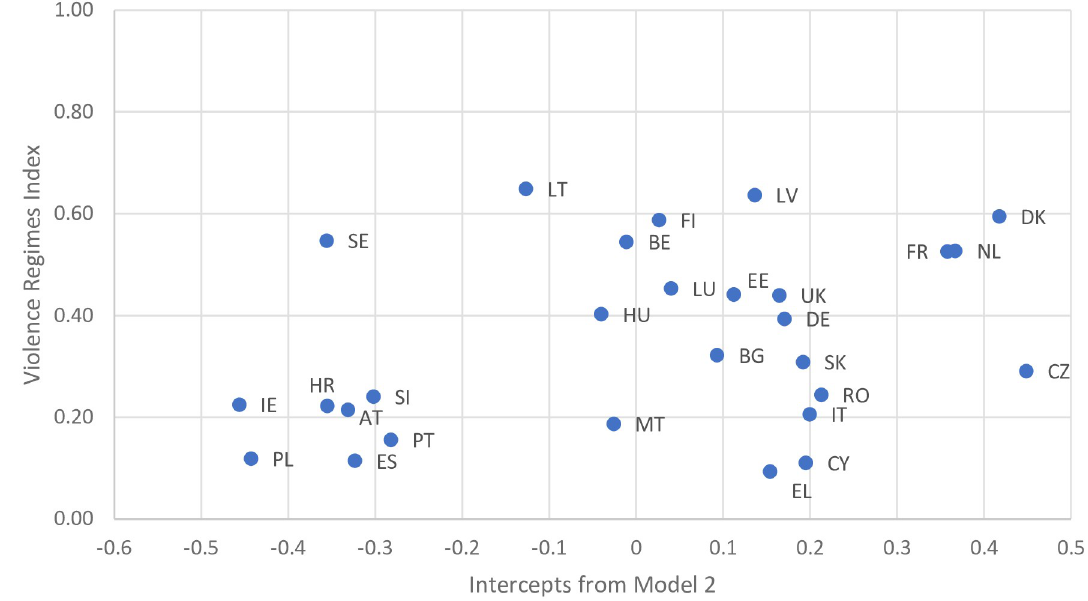
Fig 4. Relationship between adjusted levels of violence against women and the Violence Regimes Index.